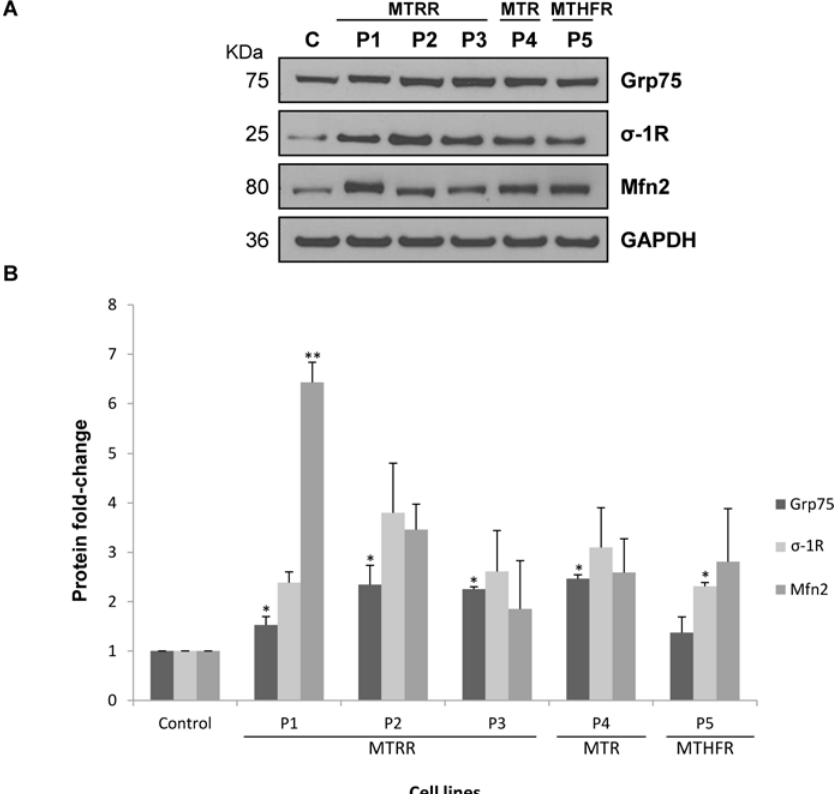
Fig 4. Analysis of MAM-associated protein levels in control and patients´ fibroblasts. (A) Equal amounts from one control and the five patients were loaded (50 μ g of total cell lysates) and subjected to Western Blot with anti-Grp75, anti- σ -1R and anti-Mfn2 antibodies. We used anti-GAPDH antibody to ensure equal amounts of protein loaded in each lane. This result is representative of three independent experiments. (B) Protein quantification was performed by laser densitometry. The ratios between proteins/GAPDH for each cell line were calculated to determine the expression fold-change relative to control. Data represent mean ± standard deviation of three independent experiments ( * P < 0.05; ** P <